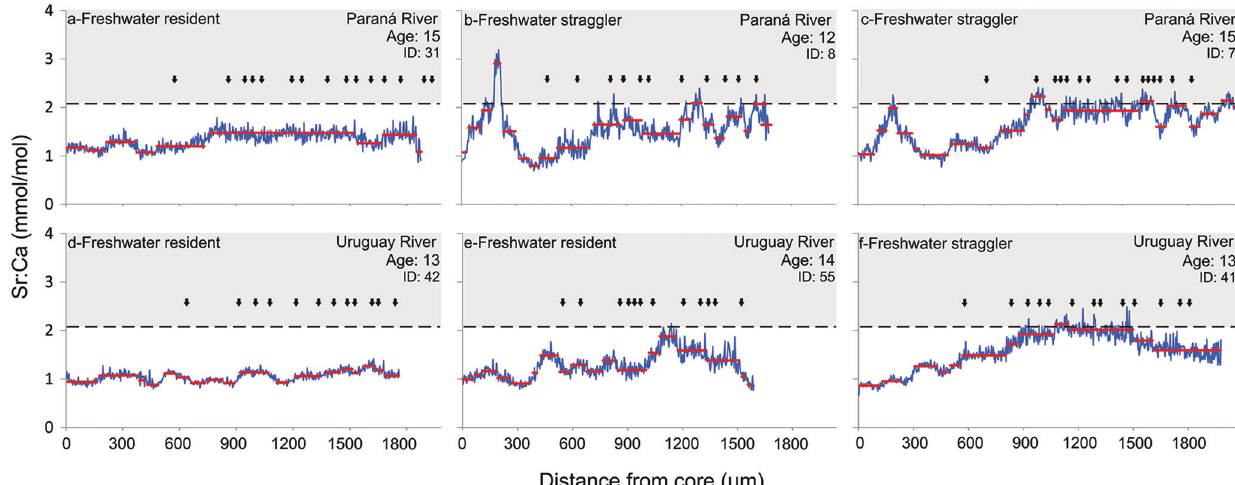
Fig. 4. Otolith microchemical profiles of Prochilodus lineatus from core to edge (age: 12-15). Vertical arrows indicate otolith annuli (age) and black dashed line indicate upper (brackish) and lower (freshwater) thresholds for Sr:Ca. Horizontal lines illustrate stable signatures identified by using change-point analysis for the Sr:Ca ratio. Quantification of changes in the life history. The global average (mean ± SD) for the number of changes of environment (or change points per transect) was 20.5 ± 5.4 (range: 9-33). Number of changes in transects of Sr:Ca were 18.5 ± 5.3 and 22.5 ± 5.6 for Uruguay and Paraná Rivers,